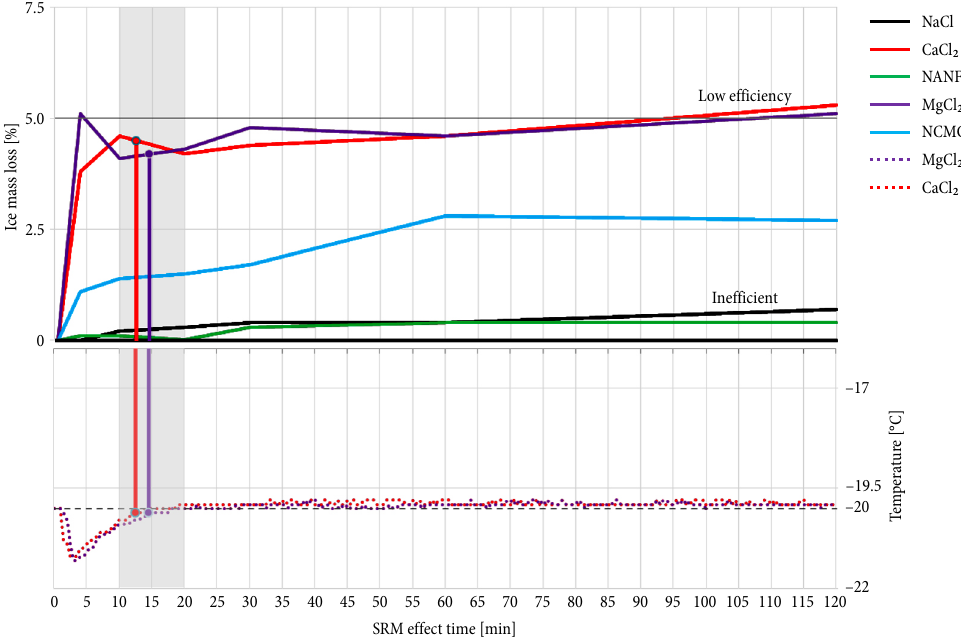
SRM effect time Fig. 3. Loss of ice mass and the change in surface temperature ( t = –20 °C) (Bulevičius et al. 2014)